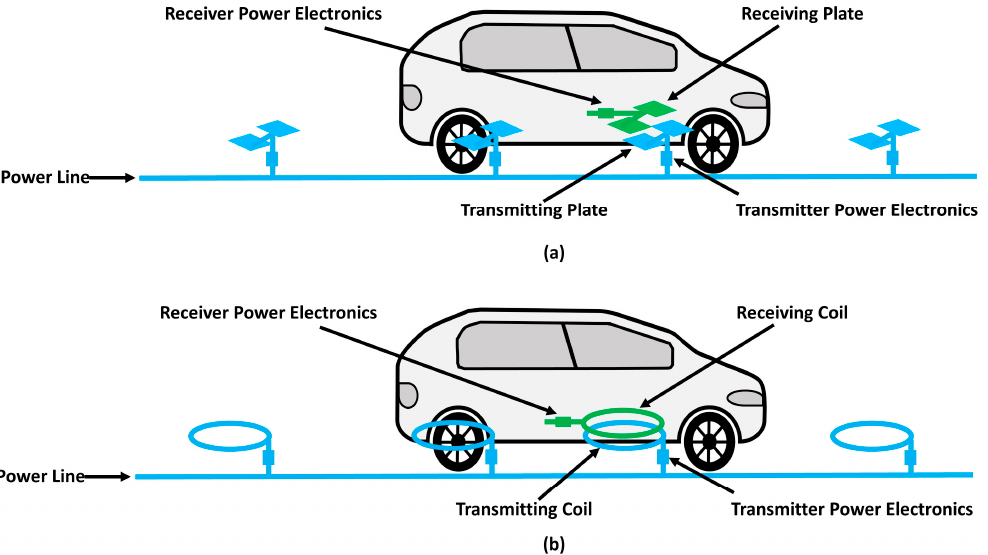
Figure 13. The physical implementation of two approaches to deliver energy wirelessly to electric vehicles from an electrified roadway: ( a ) inductive wireless power transfer (WPT) using coils (embedded in the roadway and the vehicle) that are coupled through magnetic fields; and ( b ) capacitive WPT using plates coupled through electric fields [54].